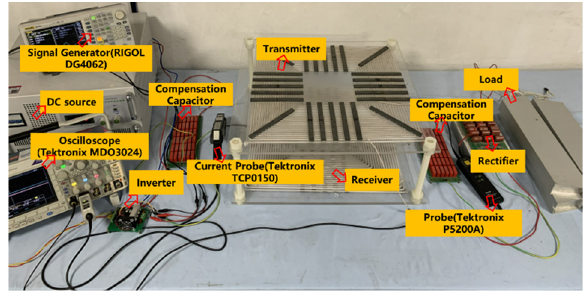
Figure 15. EVs wireless charging experimental platform. Table 2. System electrical parameters.